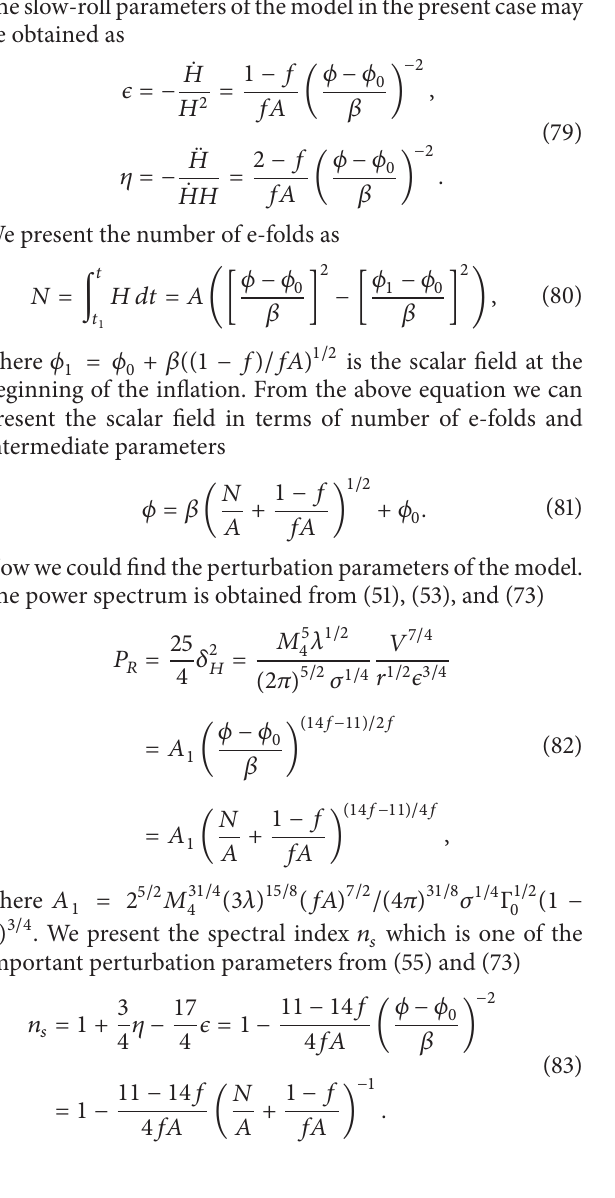
Figure 1: In this graph we plot the spectral index 𝑛 𝑠 in terms of the number of e-folds 𝑁 . We can find best range of spectral index ratio where 𝑁 > 60